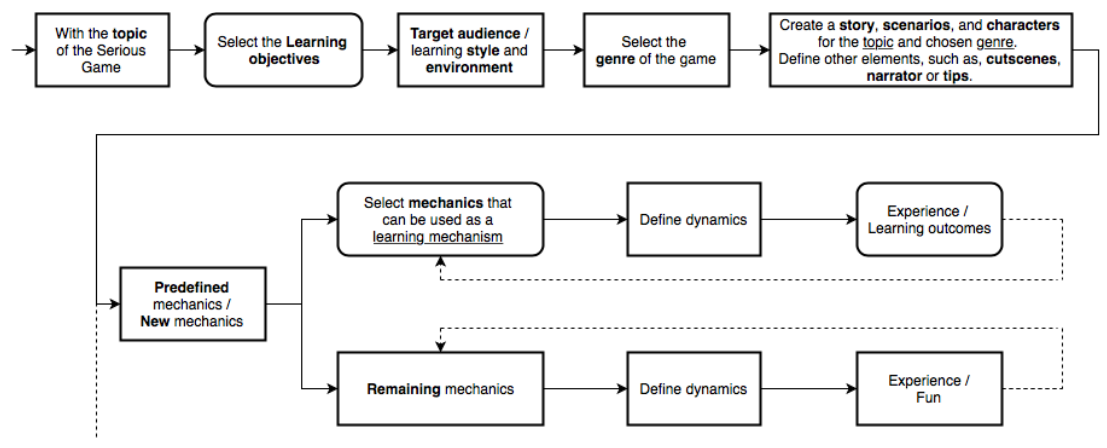
Figure 1. Main steps defining main game. Table 1. Game genres based on Bloom’s educational objectives (adapted from